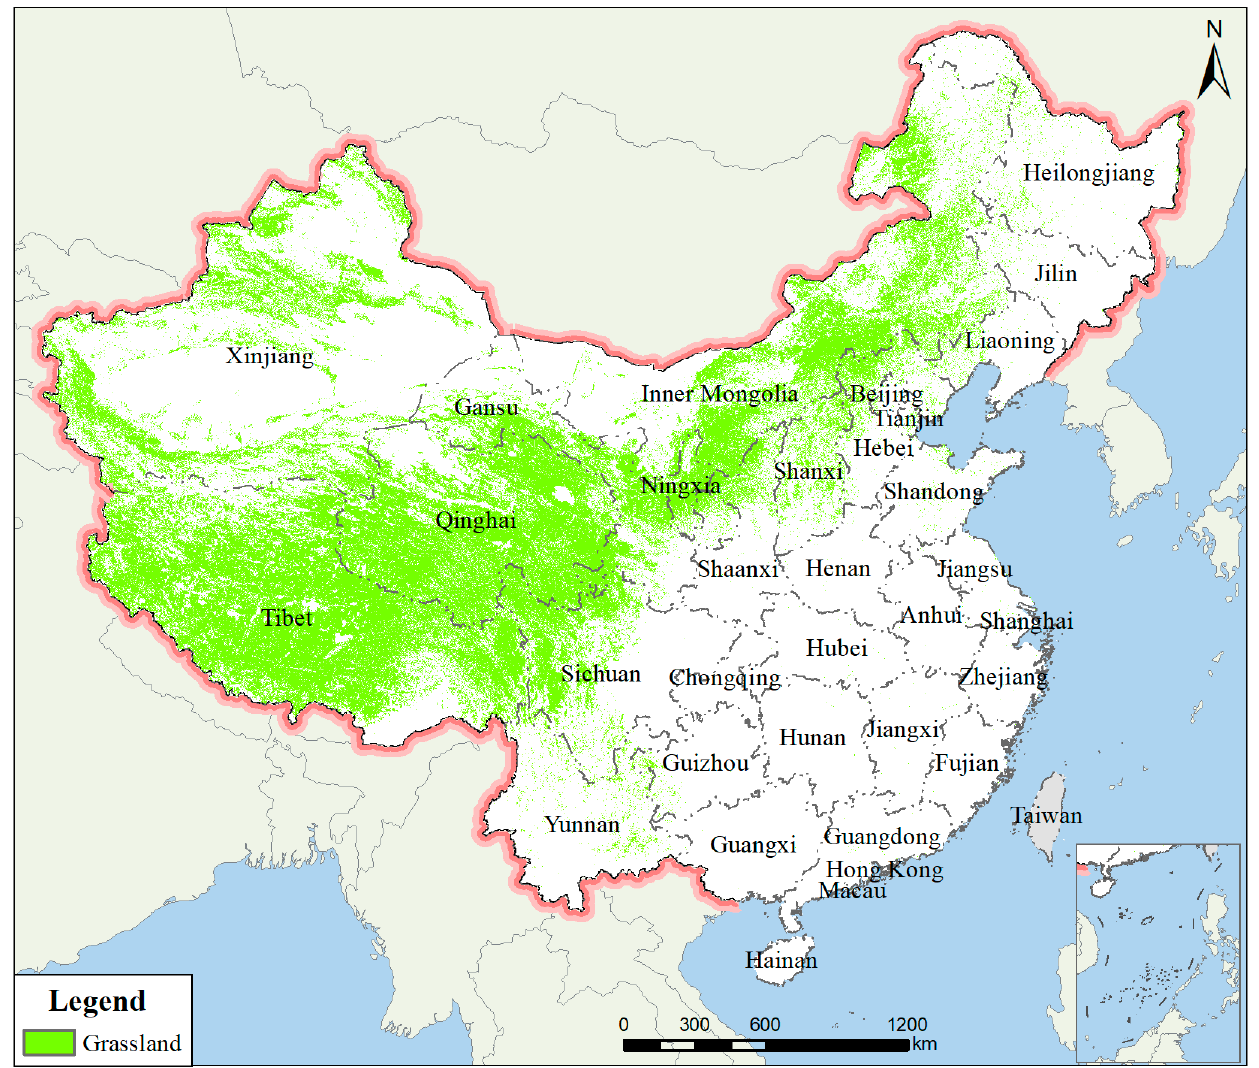
Figure 1. Study area.